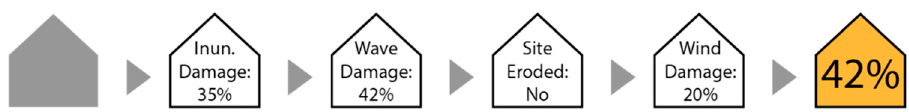
Figure 6. an example of damage modeling (similar to methods used in CERI [6]), in which a final level of damage is determined by testing building characteristics against a series of models to determine which model produces the highest and therefore controlling level of damage. Each model introduces unique assumptions and uncertainties. Unmodeled or unknowable conditions and interactions between the model create additional uncertainties [10,29]. In addition to this, the use of forensic studies introduce the problem of making calculations with vague data—that is data that is expressed in ranges rather than as a single figure [62,63]. The specificity of the numerical outcome for a specific structure, thus may create an inappropriate impression of certainty, which is further compounded by the level of detail in a realistic visualization [10]. Image: Authors.